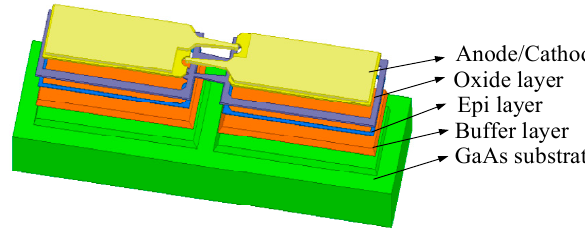
Figure 2. Layer structure of the anti-parallel Schottky diode utilized.